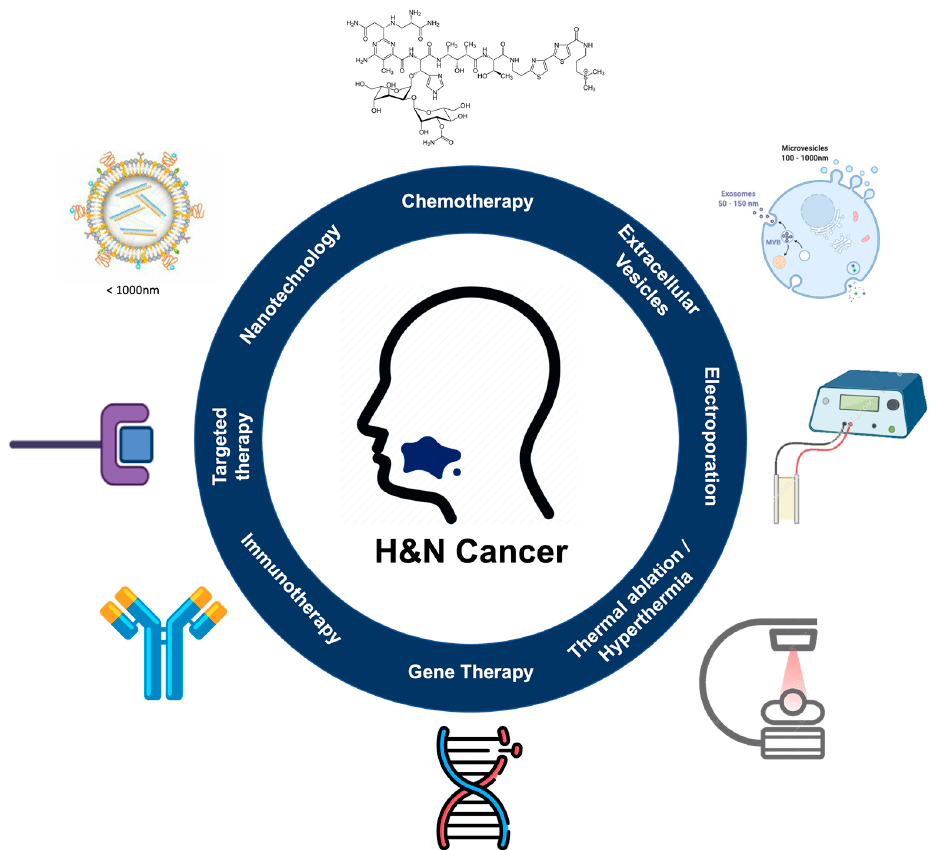
Figure 2. KEYNOTE-048, ( a ) randomized groups and treatments used; ( b ) Keytruda as a single agent and standard (Cetuximab + Cisplatin + 5-Fluorouracil); ( c ) Keytruda + chemo and standard (Cetuximab + Cisplatin + 5-Fluorouracil [37].